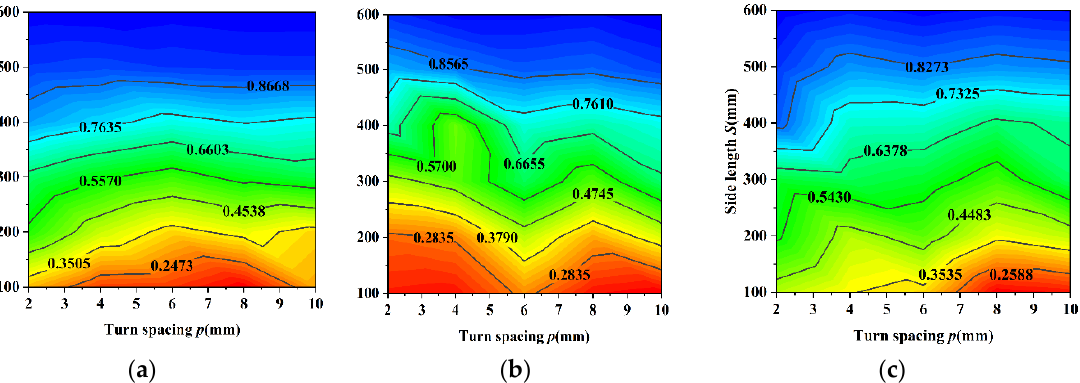
Figure 7. Variation of the uniformity coefficient α with p : ( a ) H = 100 mm; ( b ) H = 150 mm; ( c ) H = 200 mm.